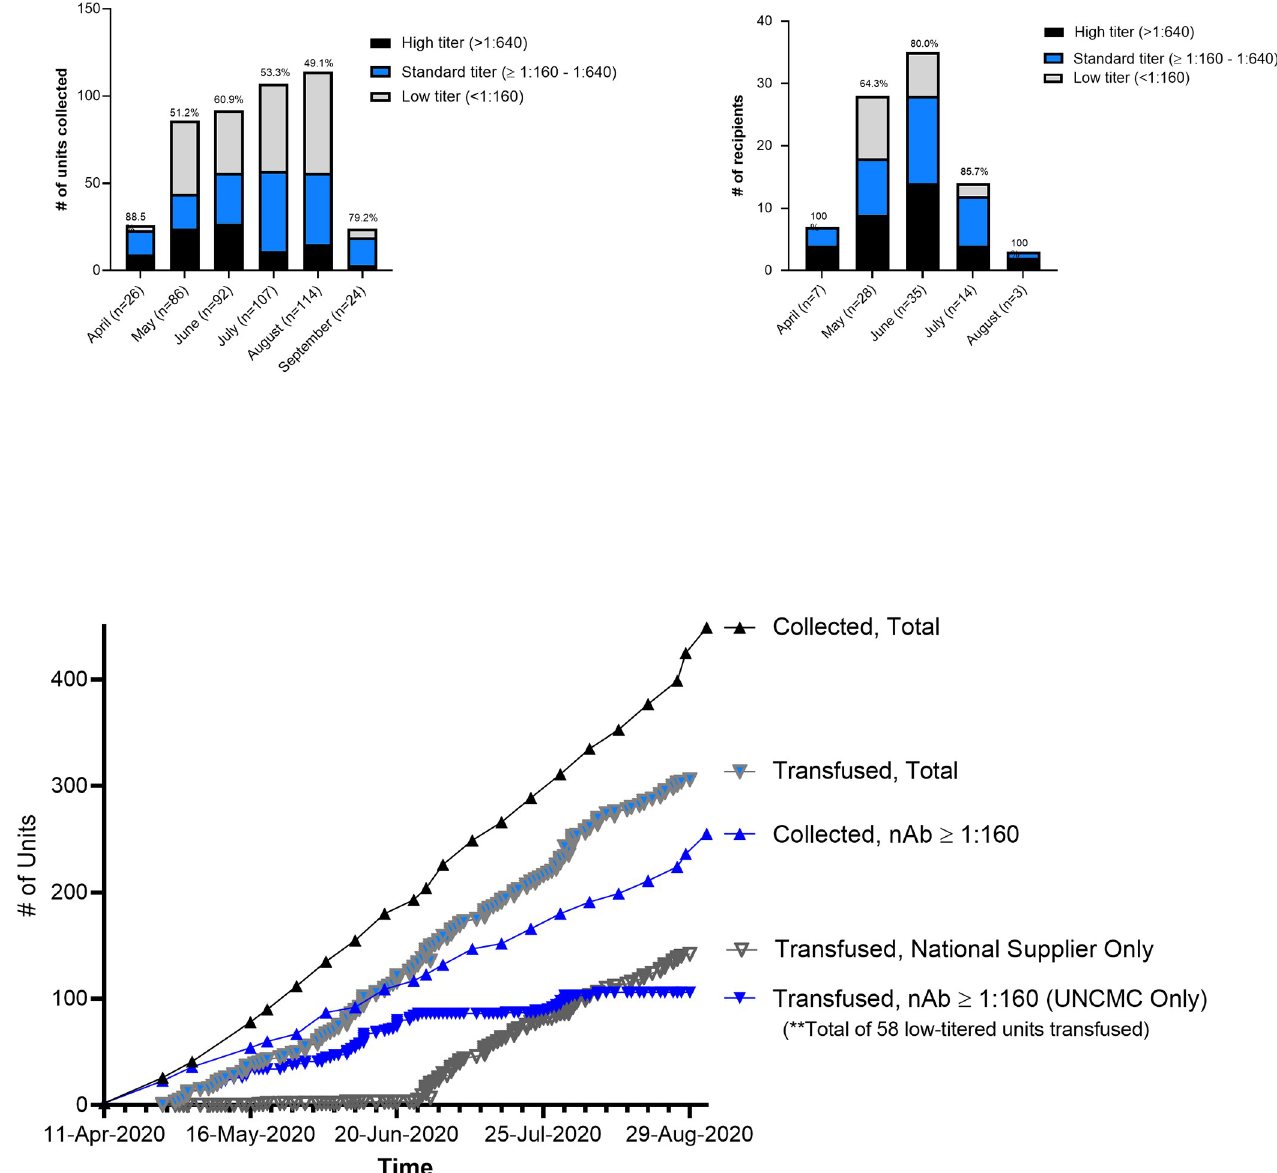
Fig 4. Proportions and cumulative titered units collected and transfused during the EAP era at UNCMC. (A) Monthly proportions of low (gray) versus standard (blue) versus high (black) titered units collected. Percentages at tops of bars are cumulative proportions of standard + high titered units. (B) Monthly proportions of low (gray) versus standard (blue) versus high (black) titered units transfused. Percentages at tops of bars are cumulative proportions of standard + high titered units. (C) Cumulative total units collected and transfused over time, cumulative units with titers � 1:160 collected and transfused over time, cumulative national supplier units transfused over